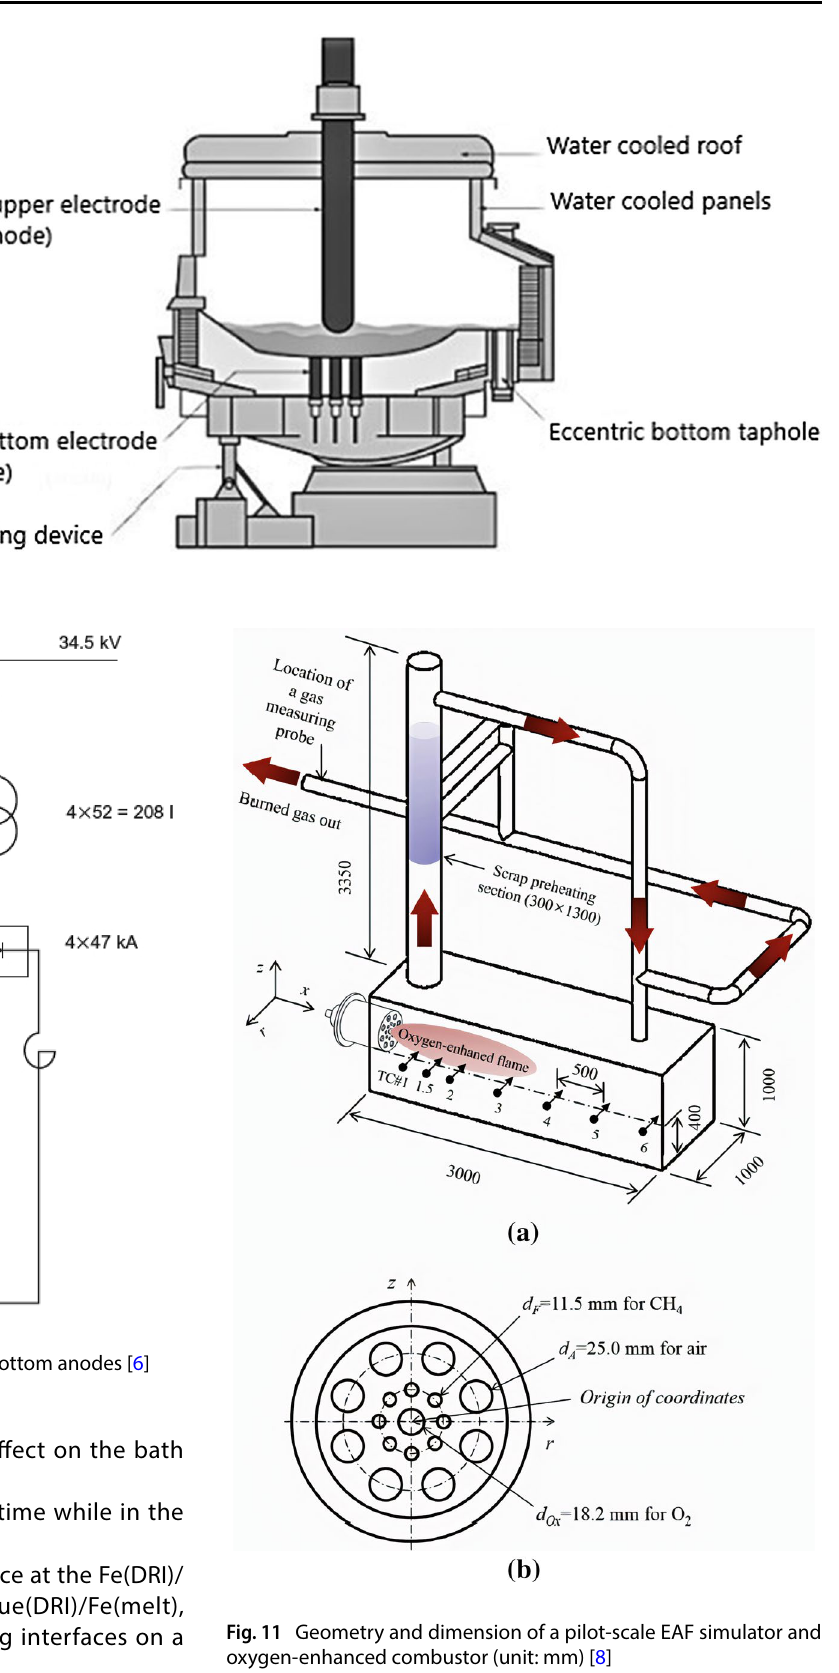
Fig. 11 Geometry and dimension of a pilot-scale EAF simulator and oxygen-enhanced combustor (unit: mm)